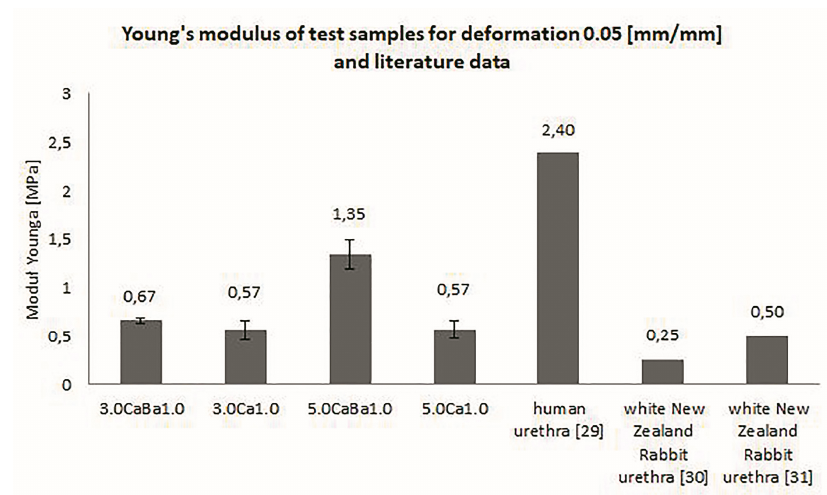
Figure 4. Young’s modulus values for tubular alginate samples obtained in mechanical testing.